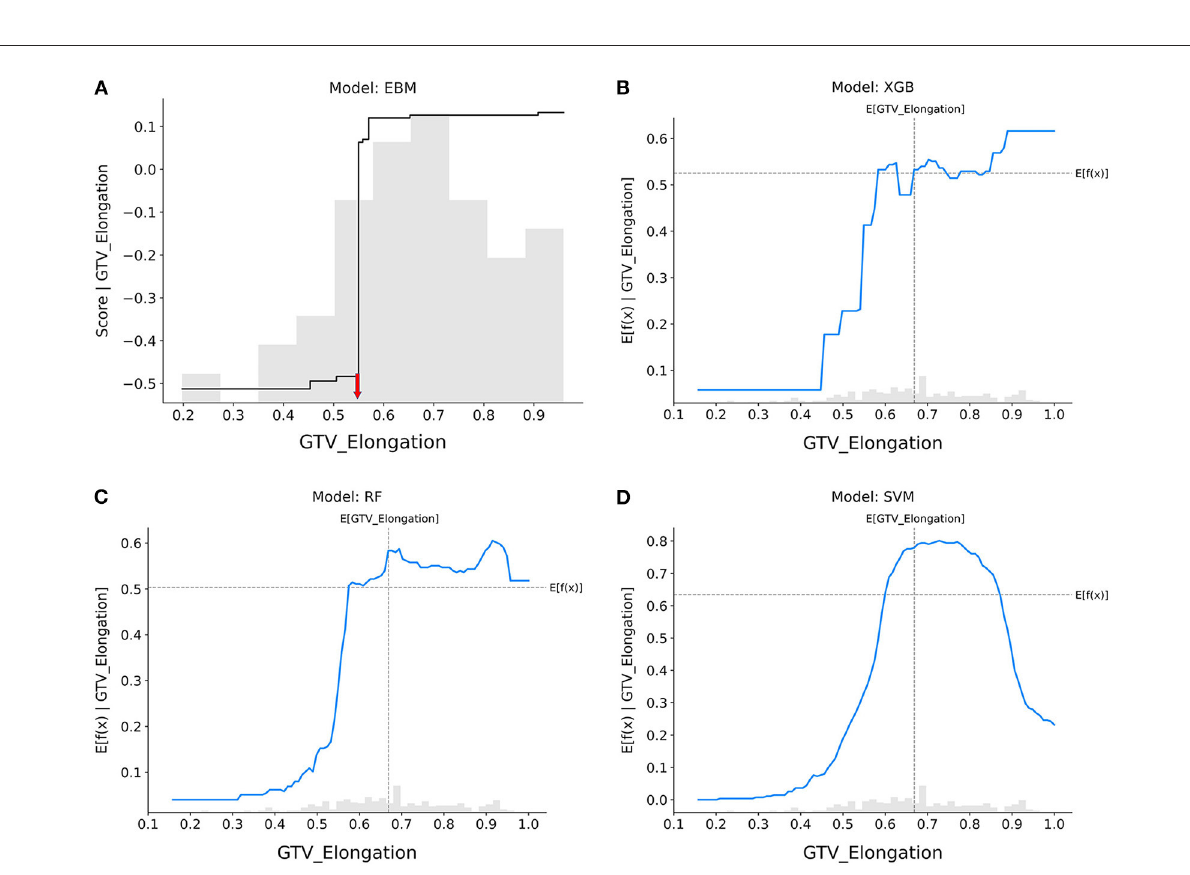
FIGURE3 Response score plots for GTV_elongation. (A) EBM shape function and SHAP partial dependence functions for the (B) XGB, (C) RF, and (D) SVM